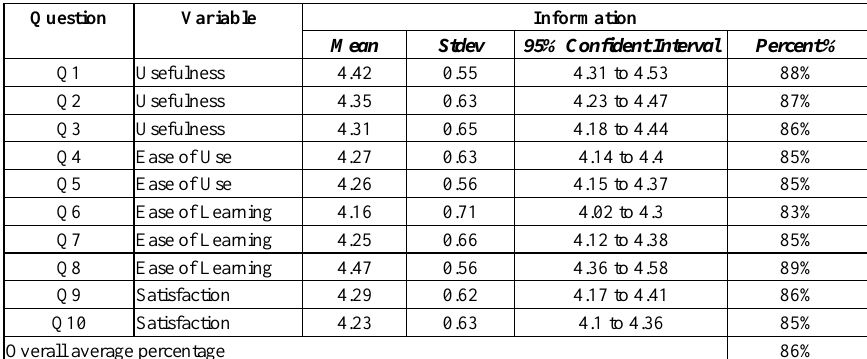
Table 5. The results of the user's perspective